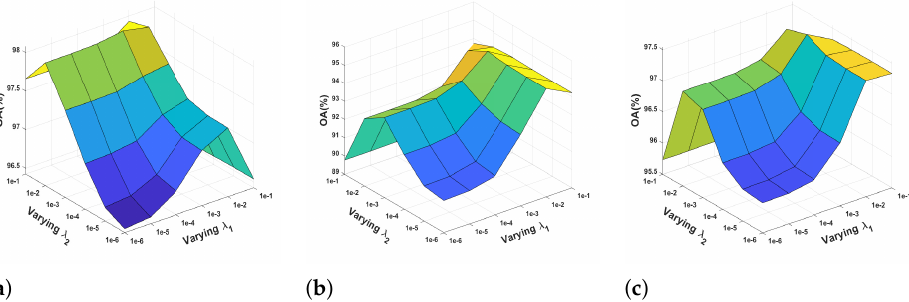
Figure 7. Impact of the regularization parameters for ( a ) Flevoland dataset, ( b ) Yihechang dataset, and ( c ) San Francisco